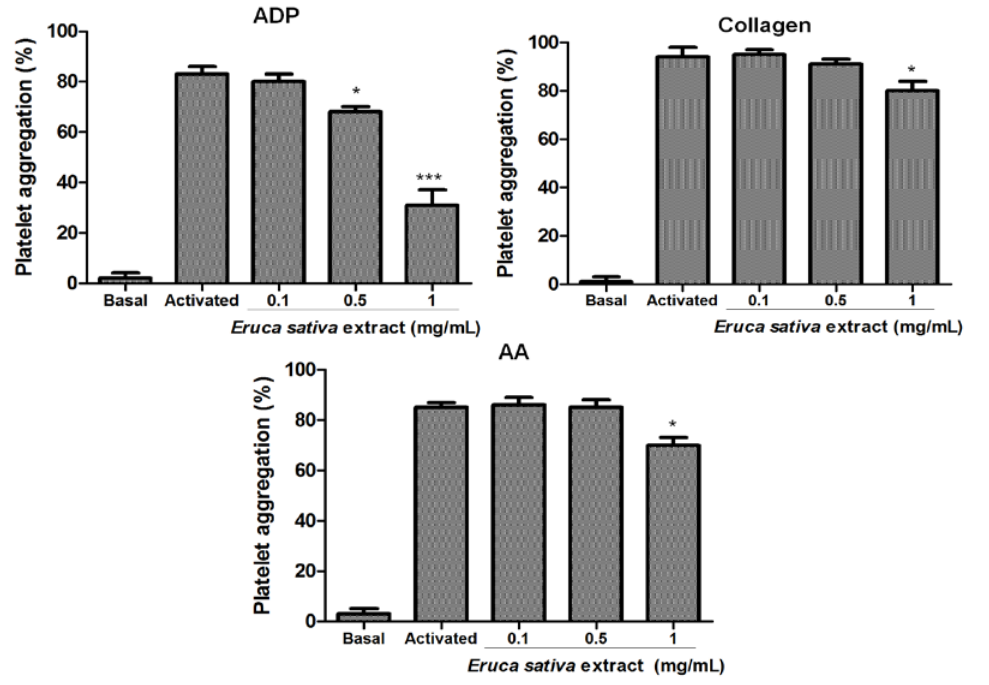
Figure 2. Effects of Eruca sativa Mill. extract on ADP (8 μmol/L), collagen (1.5 µg/mL) and AA (1 mmol/L) induced platelet aggregation. Results were expressed as platelet aggregation (%) (mean ± SEM, n = 6). Asterisks (* p < 0.05 and *** p < 0.001) denote a statistically significant difference when compared with the activated control analyzed by one-way ANOVA and Tukey’s post hoc test. AA = arachidonic